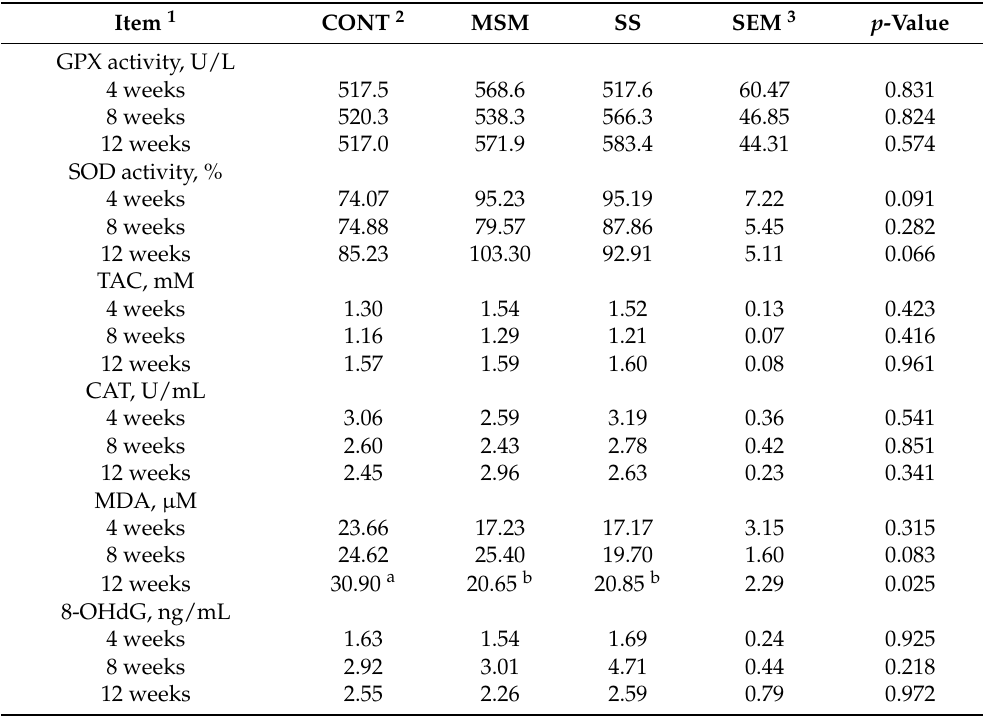
Table 9. Effects of dietary sulfur on oxidative stress markers of serum in laying hens ( n = 8). Item 1 CONT 2 MSM